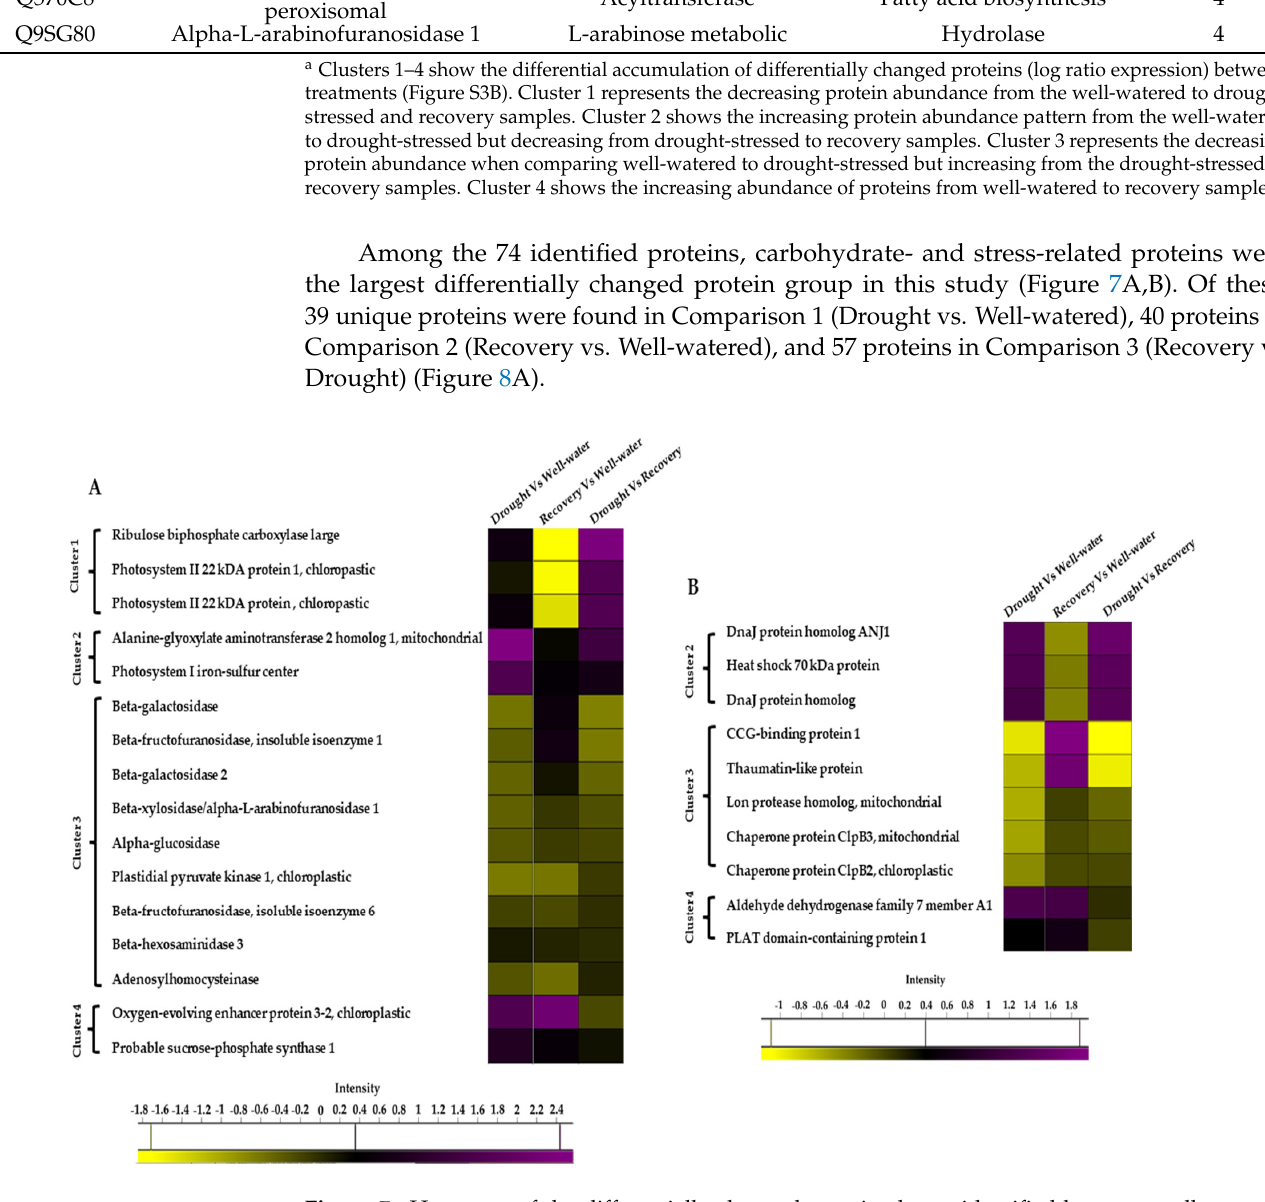
Figure 7. Heat map of the differentially changed protein classes identified between well-watered, drought-stressed, and water-recovered Pandanus amaryllifolius . ( A ) Carbon-related proteins identified between treatments. ( B ) Stressed-related proteins identified between treatments. The intensity scale indicates the range of upregulation (purple) or downregulation (yellow) of proteins between treatments.